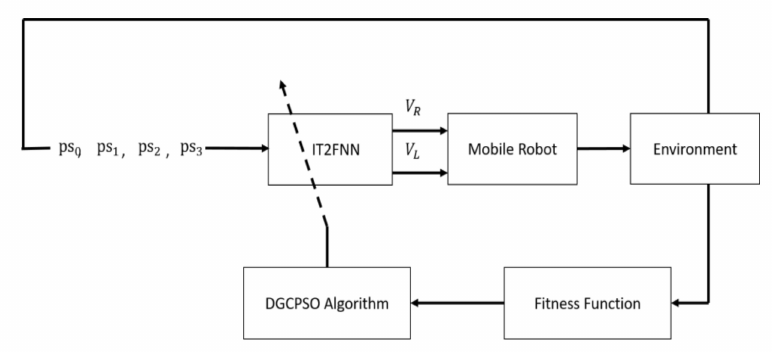
Figure 16. Block diagram of the